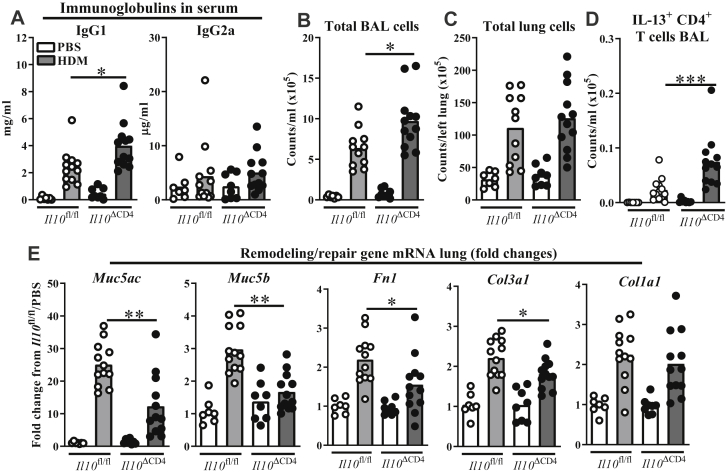
AAD parameters in HDM-treated T cell–specific IL-10 knockout mice. A, Concentrations of total IgG1 and IgG2a in serum. B and C, Total cell counts from BAL fluid (Fig E3, B) and digested lung tissue (Fig E3, C). D, Flow cytometric data showing IL-13+ CD4+ T-cell numbers in BAL fluid. E, Fold changes in mRNA expression of the indicated genes in homogenized lung tissue. Data are pooled from 2 experiments (n = 7-12 per group). *P < .05, **P < .01, and ***P < .001.